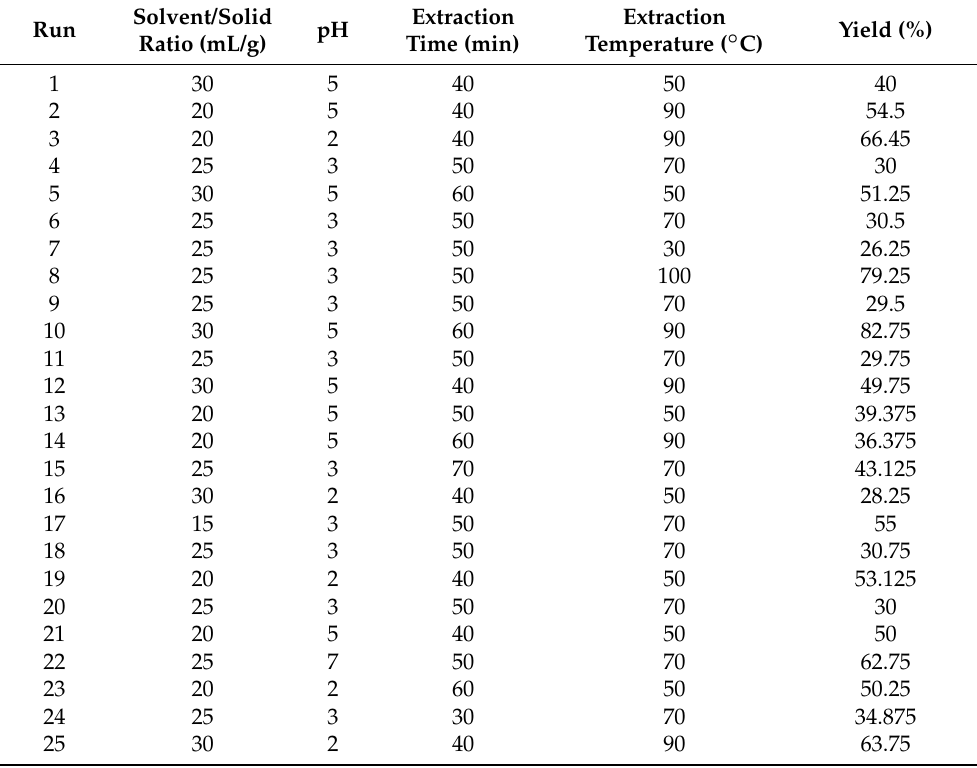
Table 2. Central composite design (CCD) used in this study and yield results by considering different solvent/solid ratio, pH, extraction time, and extraction